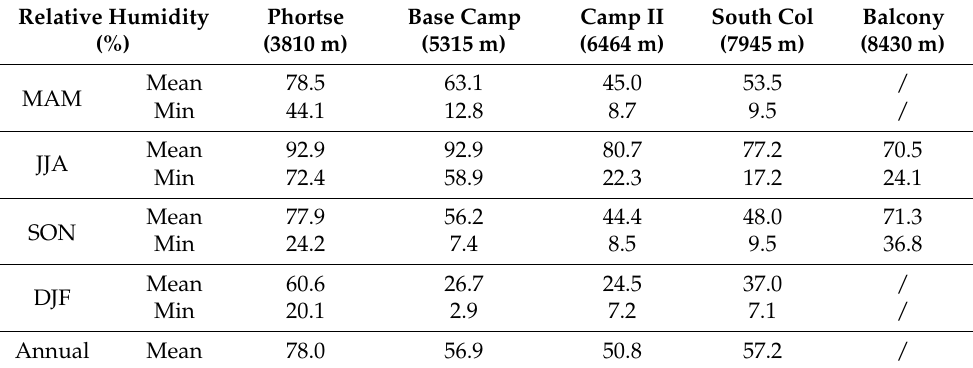
Table 3. Minimum and mean relative humidity of each season and the annual